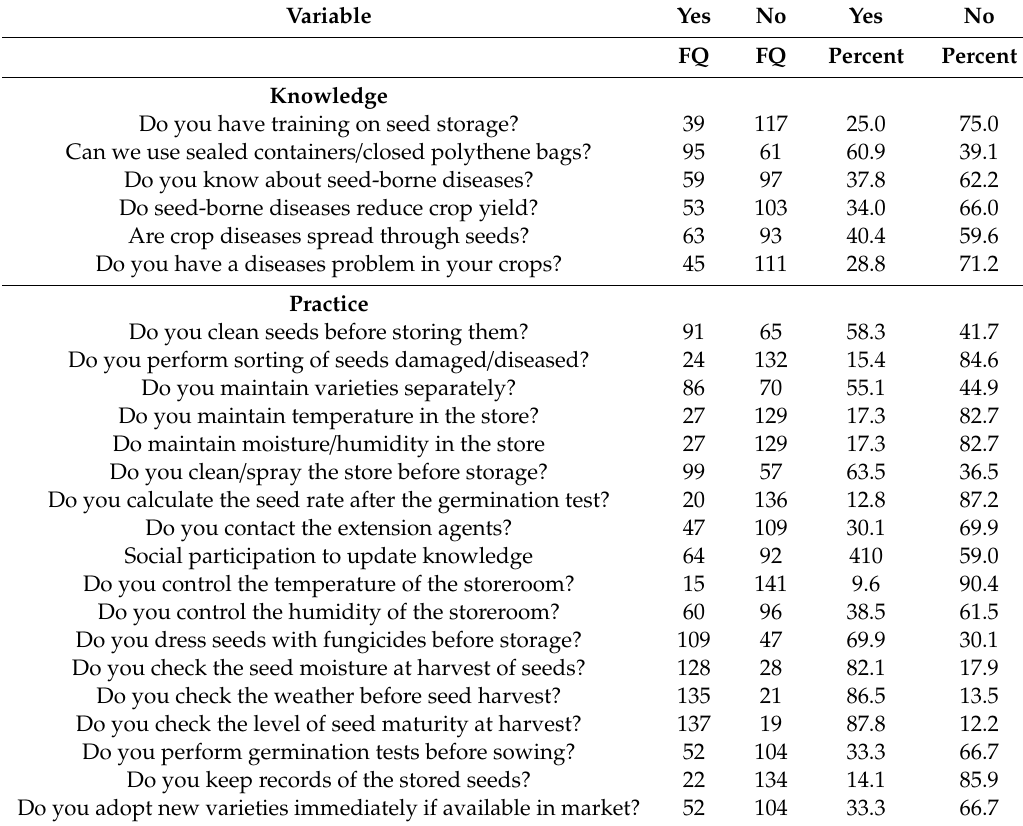
Table 3. Knowledge-based awareness of seed growers for seed storage (N =